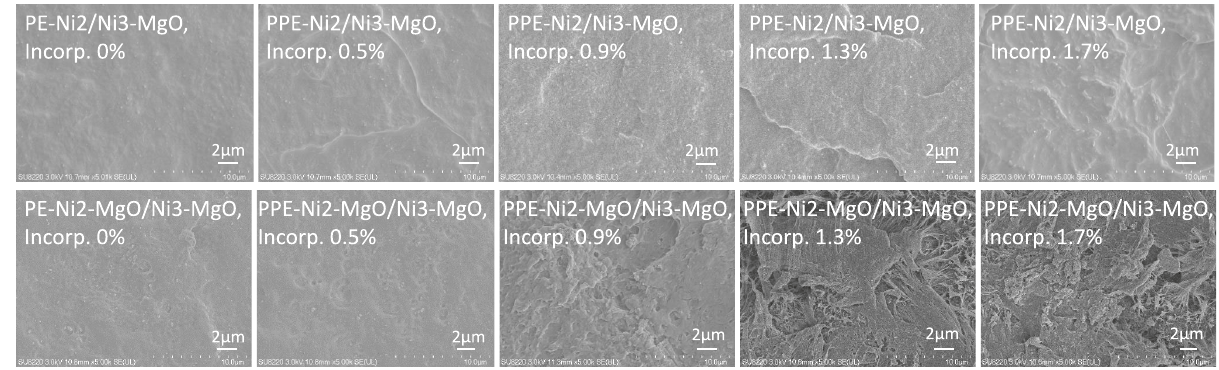
Fig. 4 | Comparison of SEM images of polar bimodal polyethylene sam- plespreparedbyco-anchoredcatalystandmixedheterogeneouscatalystafter incorporation of polar monomer. These bimodal polymers in the fi rst row were